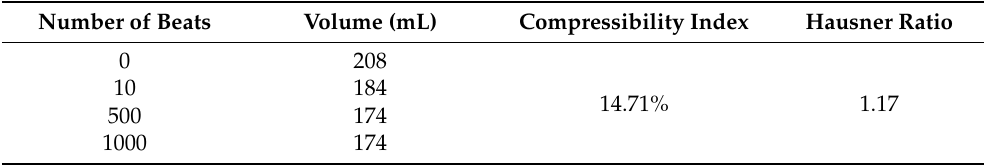
Table 2. R.m powder flow assessment.